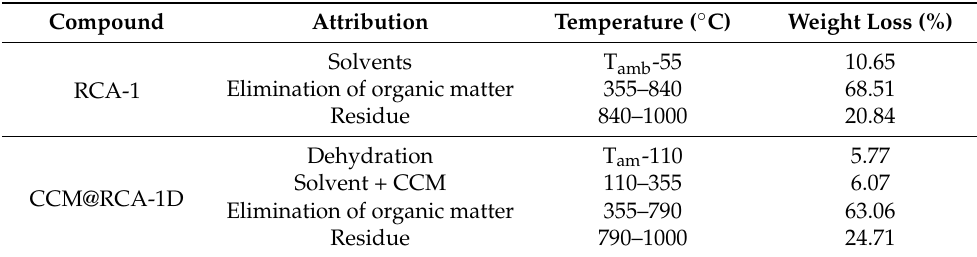
Table 4. Thermogravimetric Analysis (TGA) of compounds RCA-1 and CCM@RCA-1D.